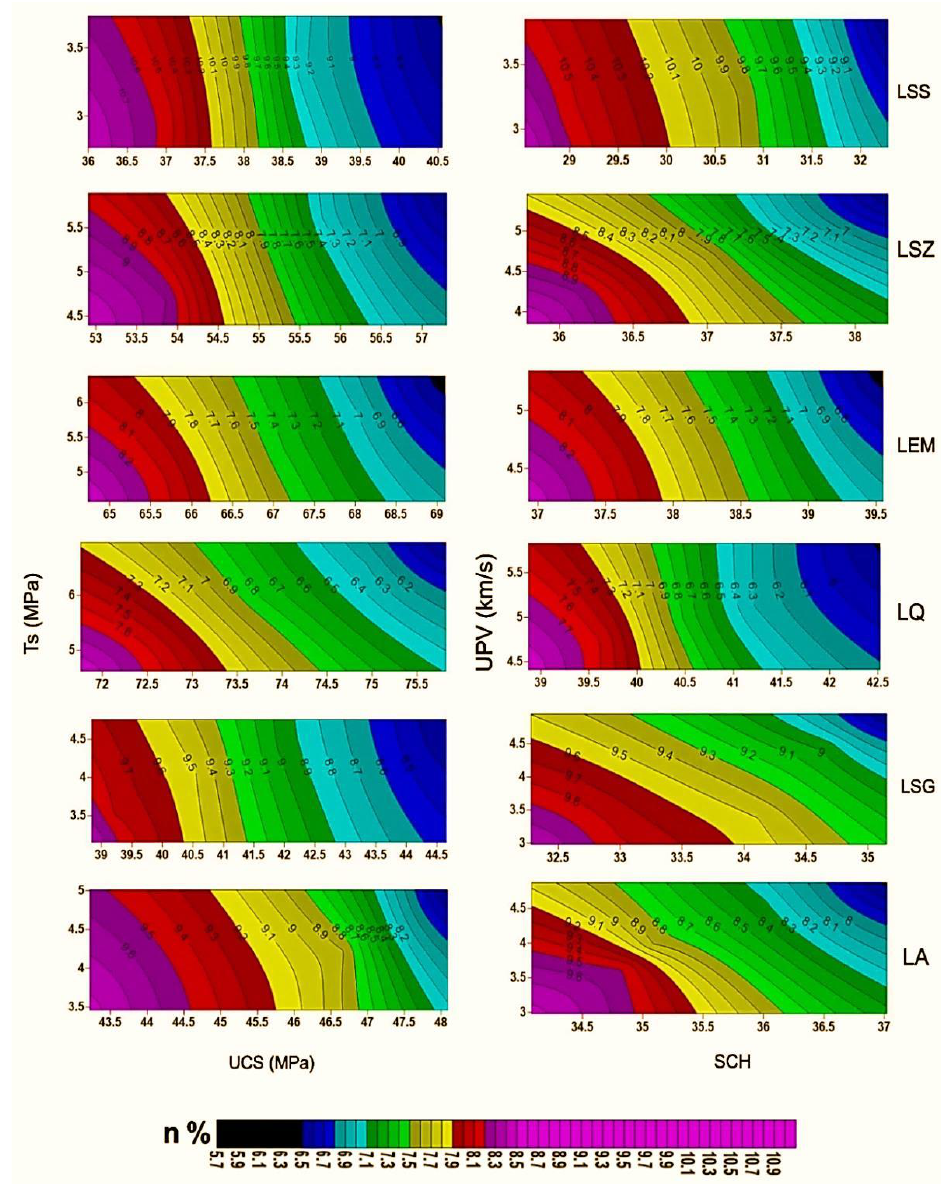
Figure 4. Influence of porosity ( n ) on T S , U CS , U PV, and S CH for the tested limestone